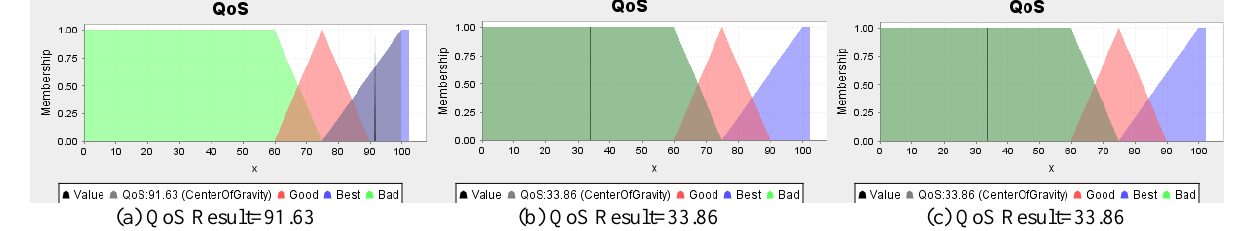
Figure 4 (a-c). QoS Results of three Sample Web